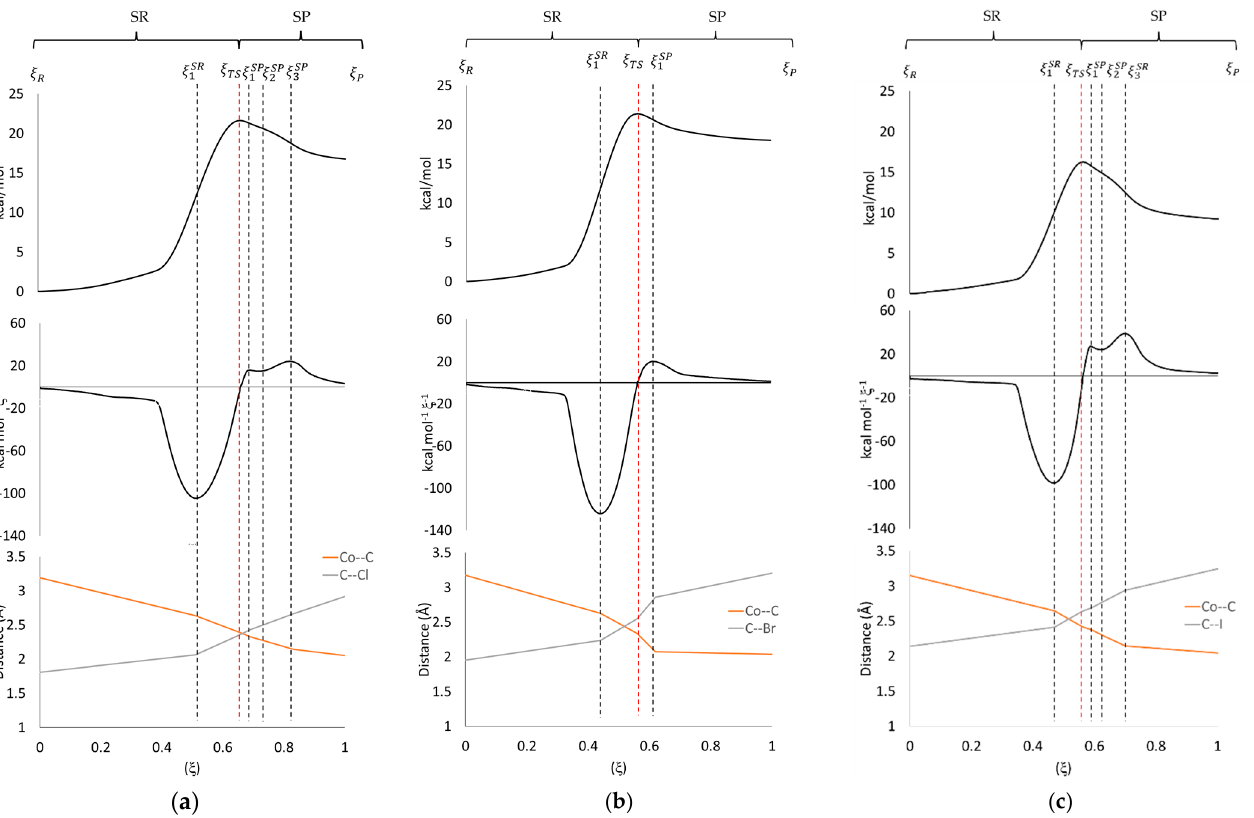
Figure 1. IRCs and reaction force curves, calculated at u ω B97-XD/6–311++G(d,p) level, for ( a ) Cl, ( b ) Br and ( c ) I as the leaving group in reaction. The dashed lines show the position of critical points in the normalized reaction coordinate.